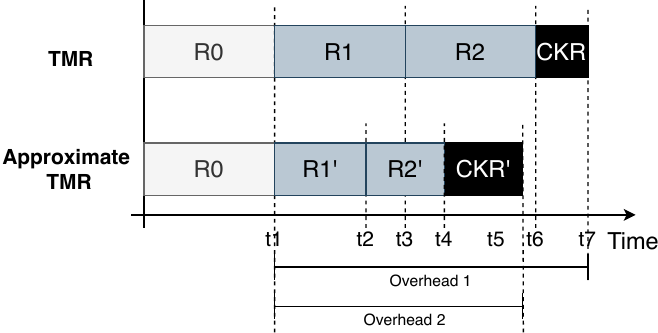
Figure 4. Example of the Approximate TMR (ATMR)